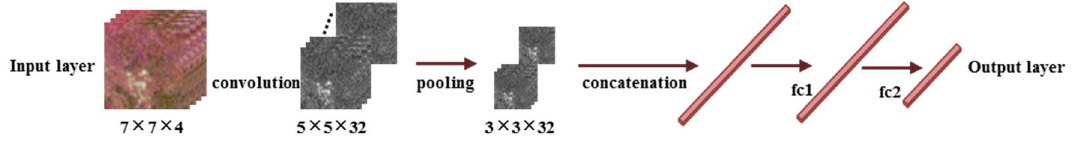
Figure 4. A typical CNN structure. The figure is adapted from Liu et al. [52].